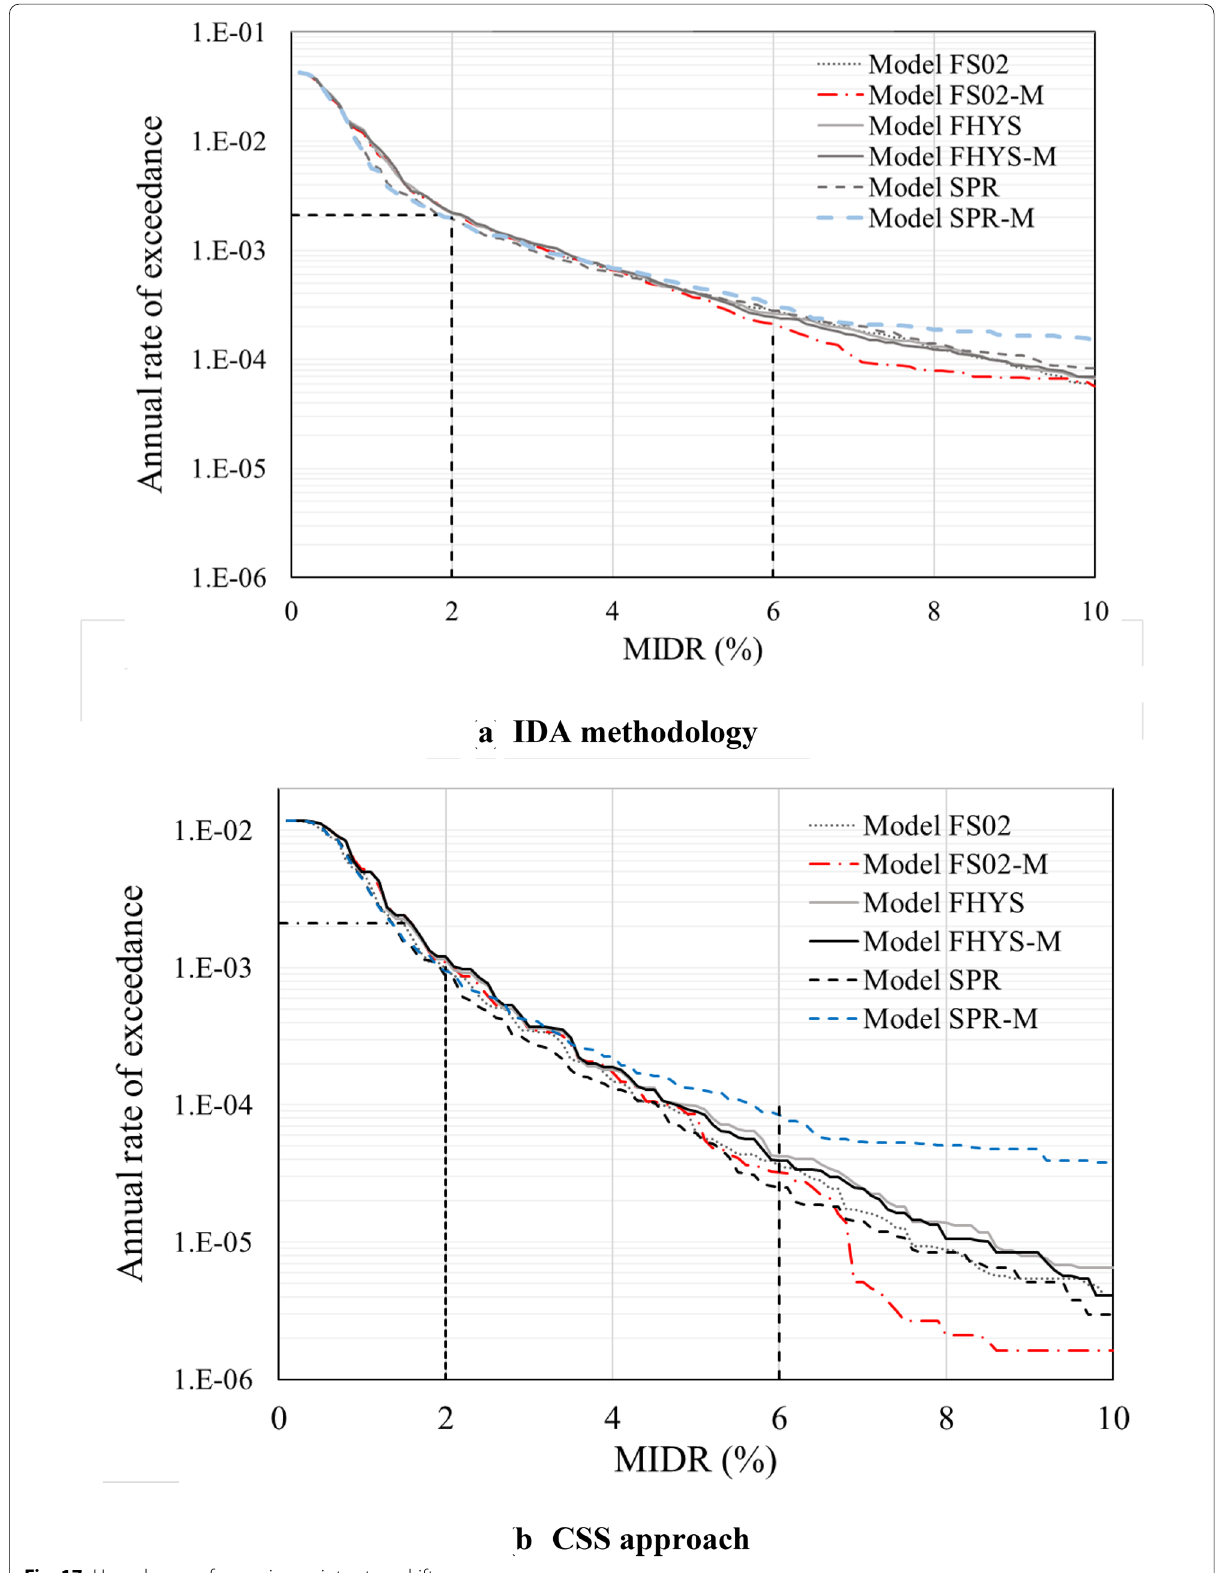
Fig. 17 Hazard curves for maximum interstory